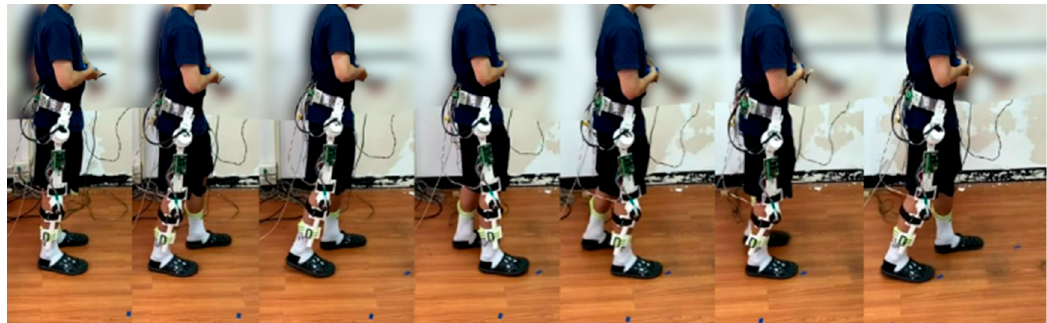
Figure 7. Walking experiments for gait training with robotic hip-knee exoskeleton.